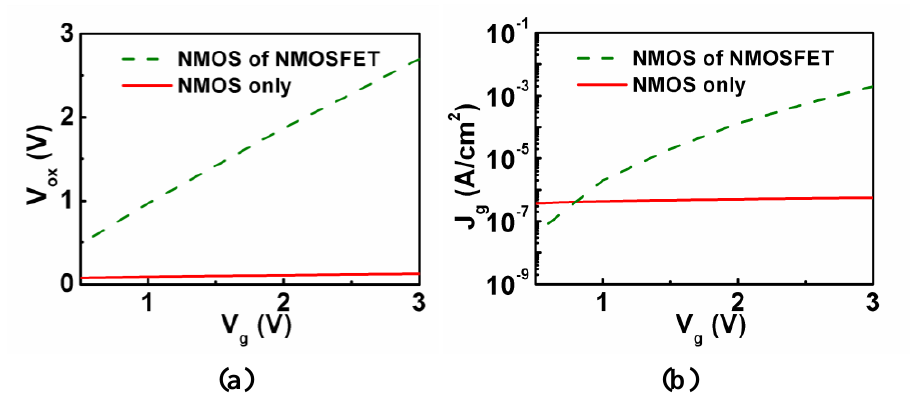
Figure 2. (a) The oxide voltage as a function of the gate voltage for a 3-nm-oxide NMOS with an NMOSFET transistor structure [8] and a 2.3 nm oxide NMOS without a transistor structure [9]; (b) Gate tunneling current density as a function of the gate voltage for a 2.9 nm oxide NMOS with an NMOSFET transistor structure [8] and a 2.3 nm oxide NMOS without a transistor structure